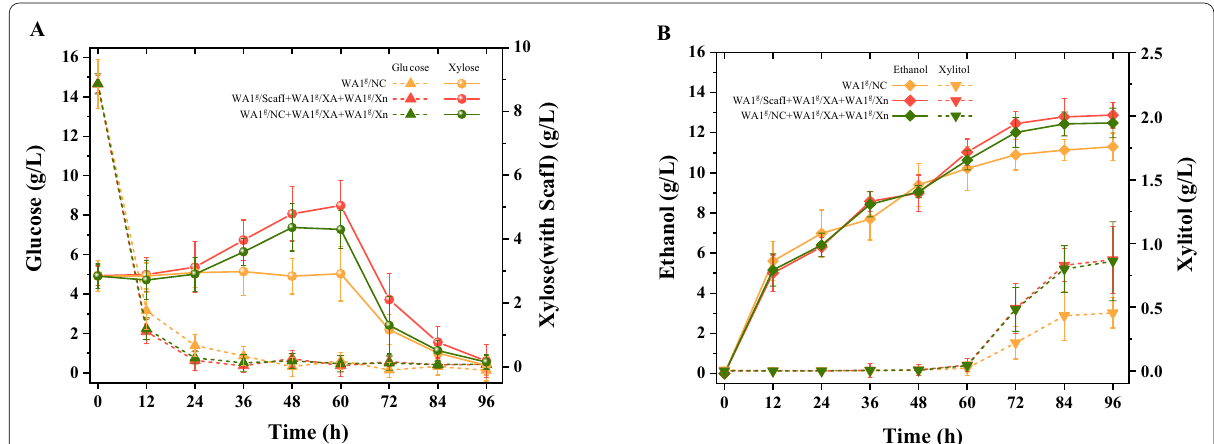
Fig. 6 Time profiles of lignocellulose hydrolysis ( A ) and ethanol production ( B ) from steam-exploded P. purpureum after 6 h pre-hydrolysis using recombinant yeast consortium